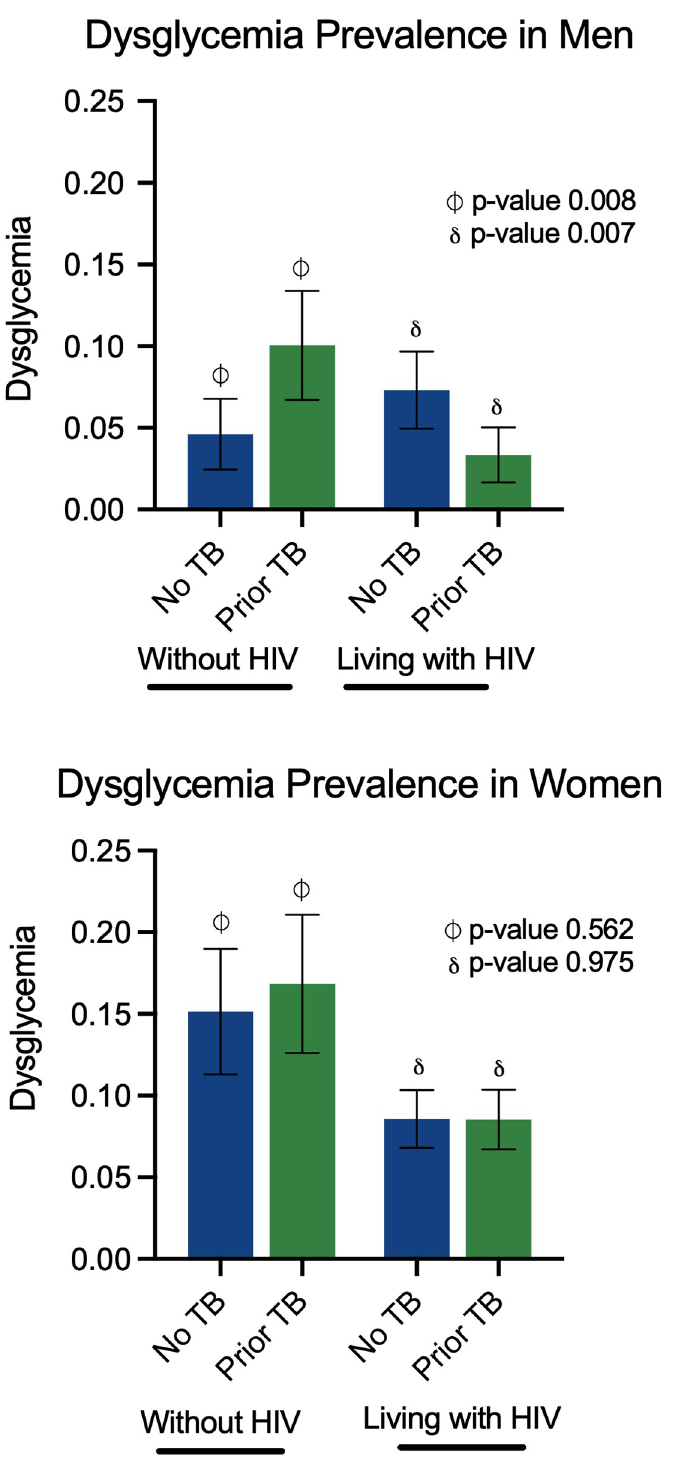
Fig 1. Prior TB and HIV interactions stratified by sex. Among men without HIV (top), dysglycemia prevalence is higher in those with prior history of TB disease compared to men without prior TB. The inverse relationship was found in men living with HIV, where dysglycemia prevalence was lower in those with prior TB. Women (bottom) did not have an association between HIV status, prior TB, and dysglycemia prevalence.